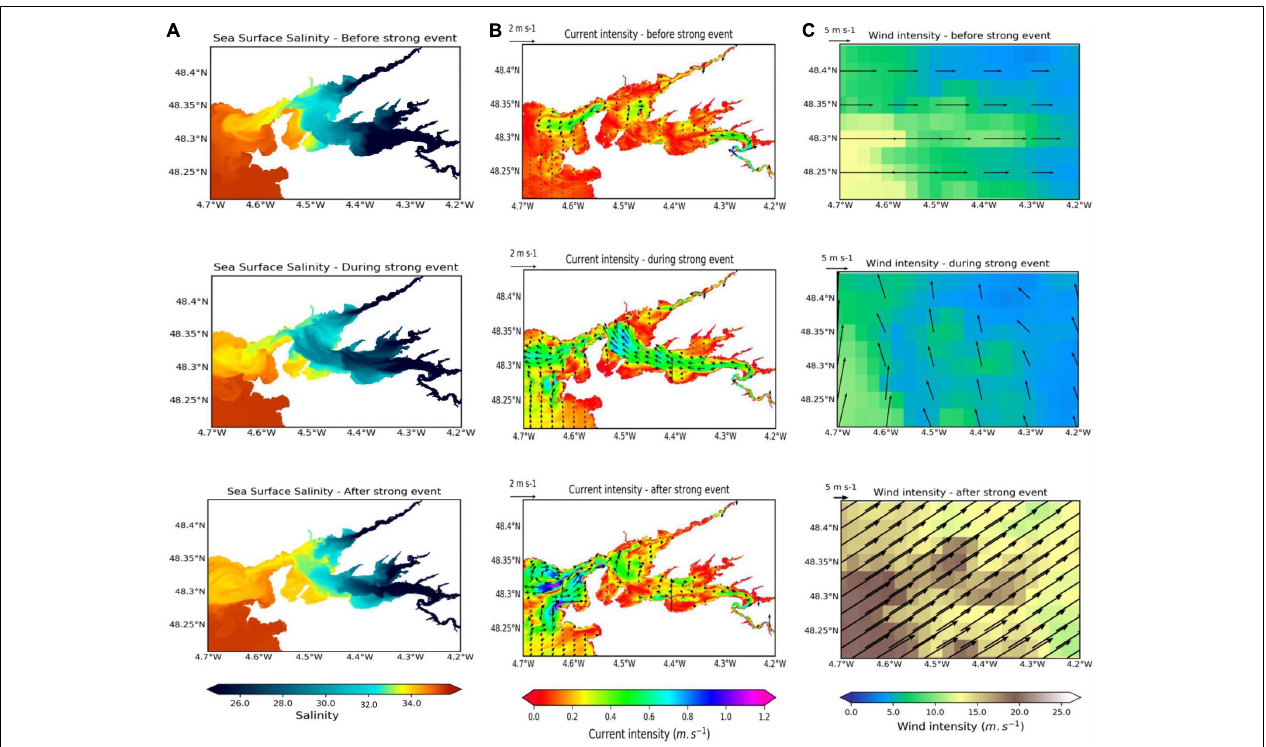
FIGURE 4 | Maps of (A) sea surface salinity at 2 m depth, (B) surface current intensity (in m s − 1 ) and its associated vectors, (C) surface wind intensity (in m s − 1 ) and its associated vectors: before (28/12/2013; upper panels), during (30/12/2013; middle panels), and after (03/01/2014; lower panels) a low salinity event during the winter